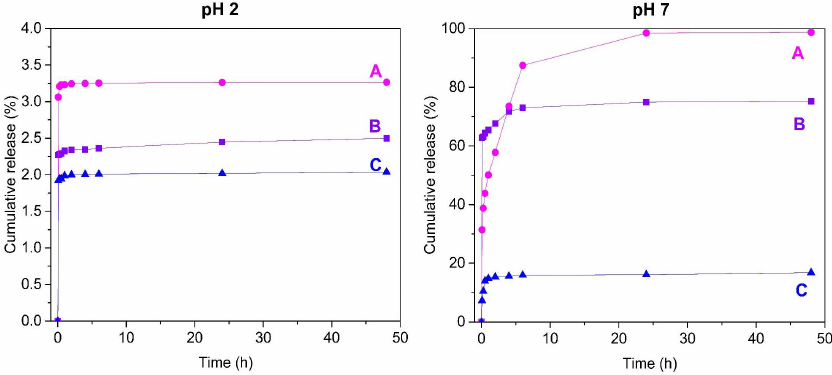
Figure 12. Release profiles of 5-fluorouracil from 5-FU-SBA-15 ( A ), 5-FU-nSBA-15 ( B ) and 5-FU-cSBA-15 ( C ) nanomaterials into the media with different